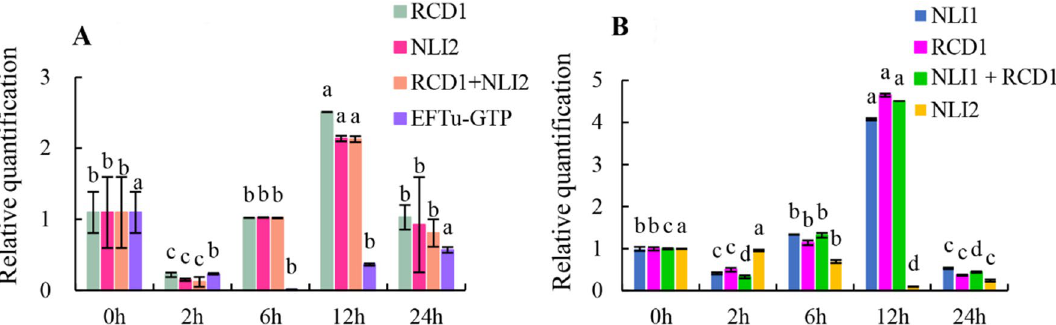
Figure 5. The relative expression level of WRKY was determined by the use of select reference genes, including the most or least stable reference genes, for normalization in the roots. ( A ) Relative quantification of WRKY expression in the roots of plants under low-temperature stress. ( B ) Relative quantification of WRKY expression in the roots of plants under salt stress. All the materials were treated for 0, 2, 6, 12 or 24 h. The error bars represent the standard errors of the means of three biological replicates. Statistical analysis was performed at different times for the same reference gene. The means with different letters are significantly different from one another (P <